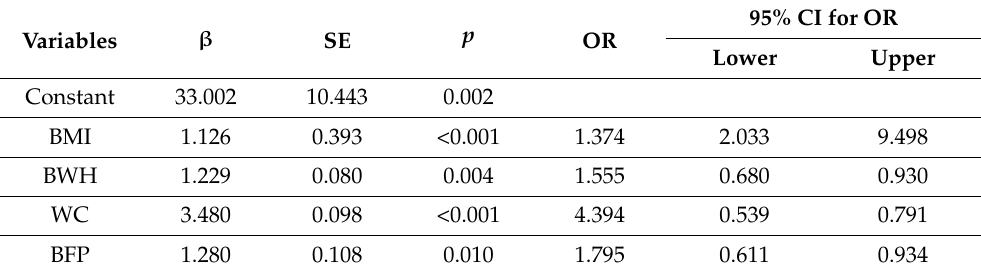
Table 5. Dual logistic regression for prognostic factors in terms of insulin resistance development in obese adolescents and children.